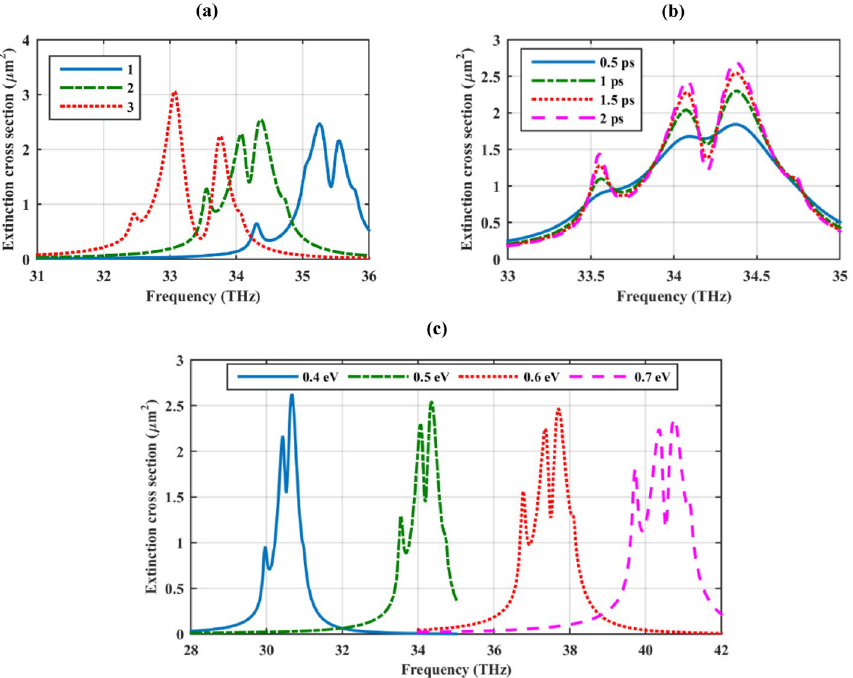
Figure 4. Variations of the extinction cross-section of the dielectric cylinder with hexamer cover by considering different ( a ) dielectric cores ( b ) graphene relaxation times and ( c ) graphene chemical potentials. The initial design parameters are as follows: r c = 500 nm, ε c = 2, r s = 100 nm, h = 250 nm, τ = 1.5 ps, and μ c = 0.5 eV. The spherical particles are considered hollow.